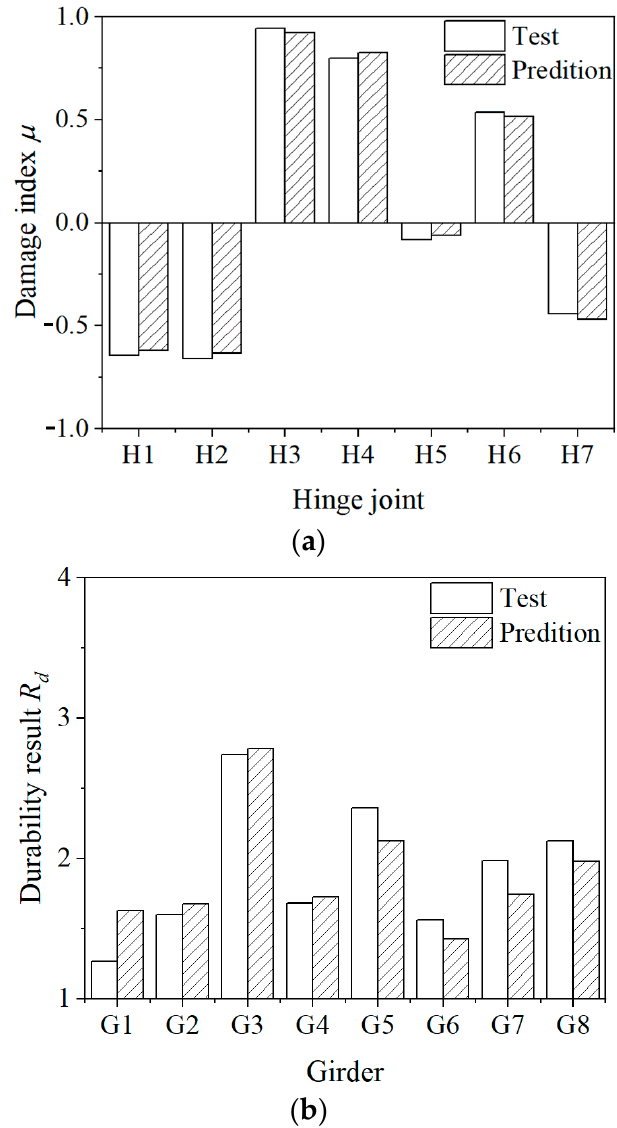
Figure 18. Predictions and test results: ( a ) hinge joint damage; ( b ) durability of the girder.